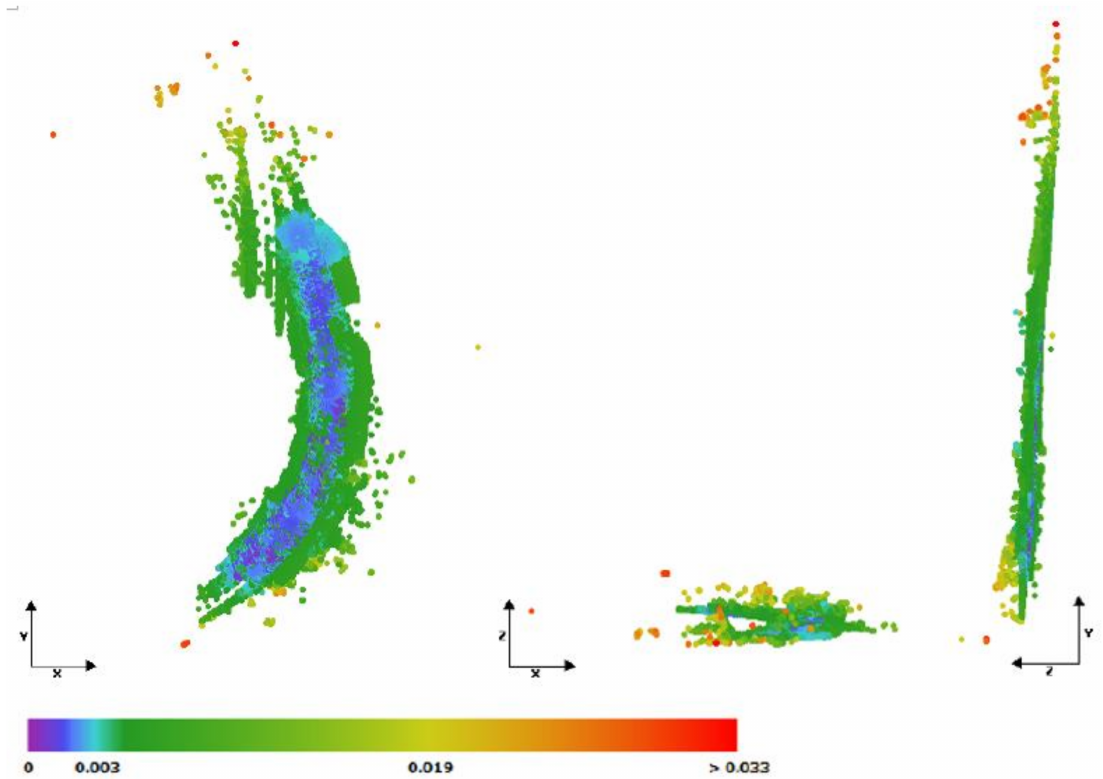
Figure 9. Resolution of tie points. Source: CC Report (m / px).